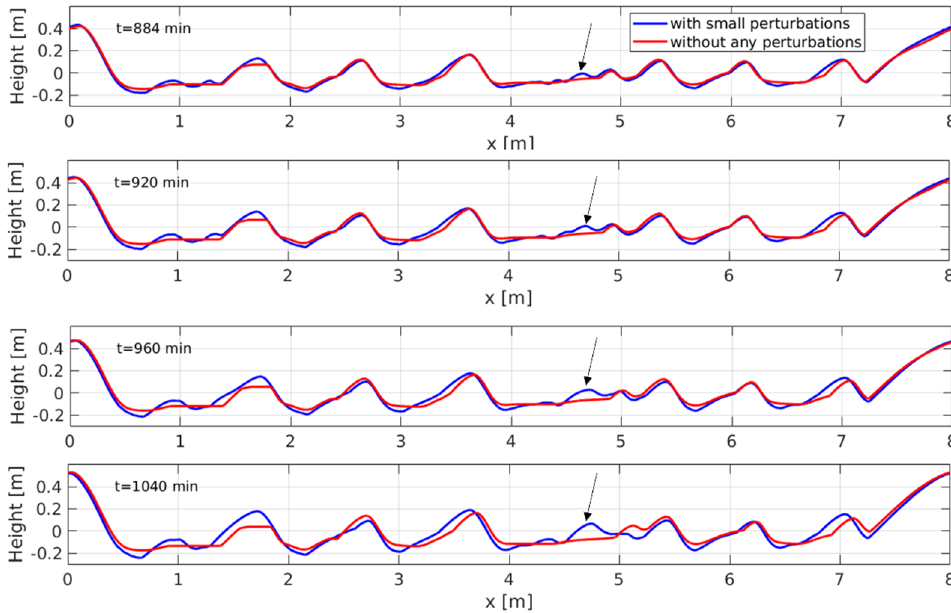
Figure 9. The effect of adding small random perturbations on the evolution of the large impact ripples. The black arrows indicate development of small ripples between the large matured ripples.